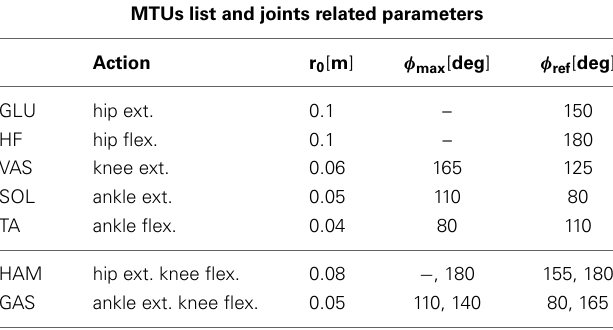
The last two rows (HAM and GAS muscles) corresponds to bi-articular muscles (i.e., they span two joints), other rows are for uni-articular muscles. The second column shows the resulting action on the joint(s) onto which the muscle acts. The third column corresponds to the lever arm used for torque calculation. The fourth column gives the angle at which the action of the muscle on the joint is maximum (absent for the hip joint). The last column gives the reference angle of the muscle (i.e., the angle that corresponds to the muscle rest